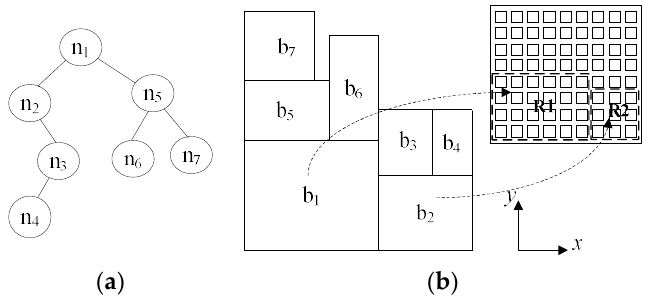
Figure 2. B*Tree structure and its corresponding placement: ( a ) B*-tree structure; ( b ) The corresponding placement.